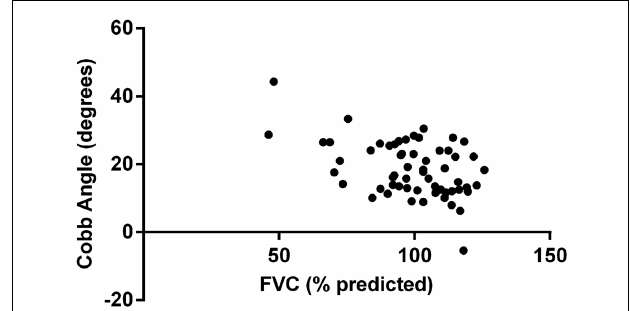
FIGURE 1 | Correlation between Cobb angle and FVC .